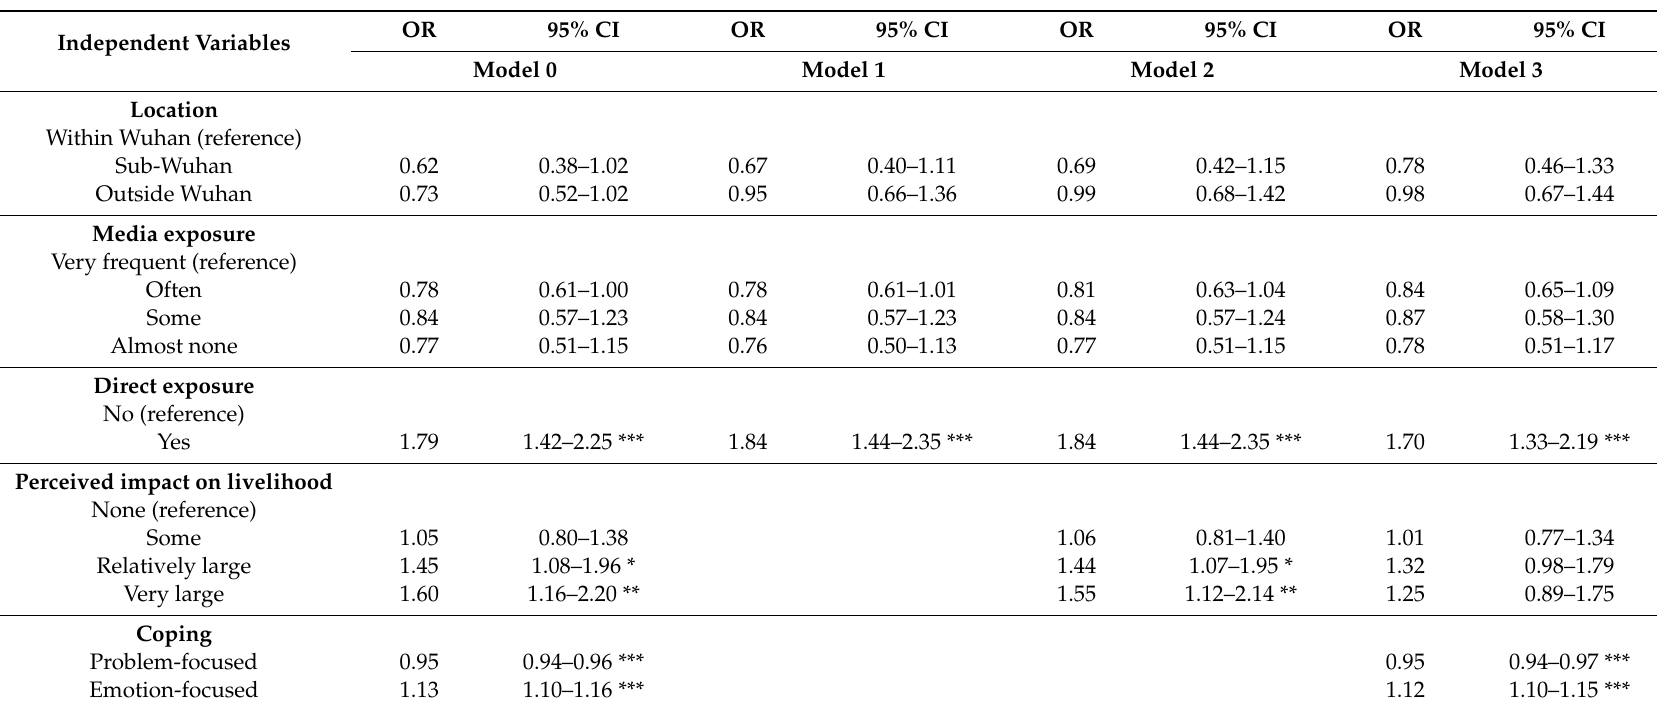
Table 5. Binary logistic regressions with exposure and coping style predicting